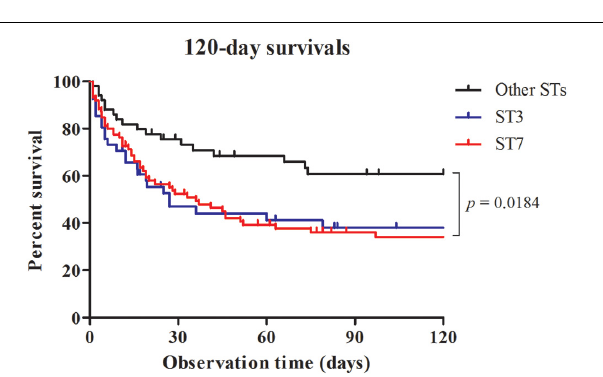
FIGURE 2 | Survival analysis for candidemia patients. Patients with bloodstream infections were grouped according to MLST type (ST3, ST7, or Other STs) and censored at death or day 120. There was a significant difference in mortality rate between the